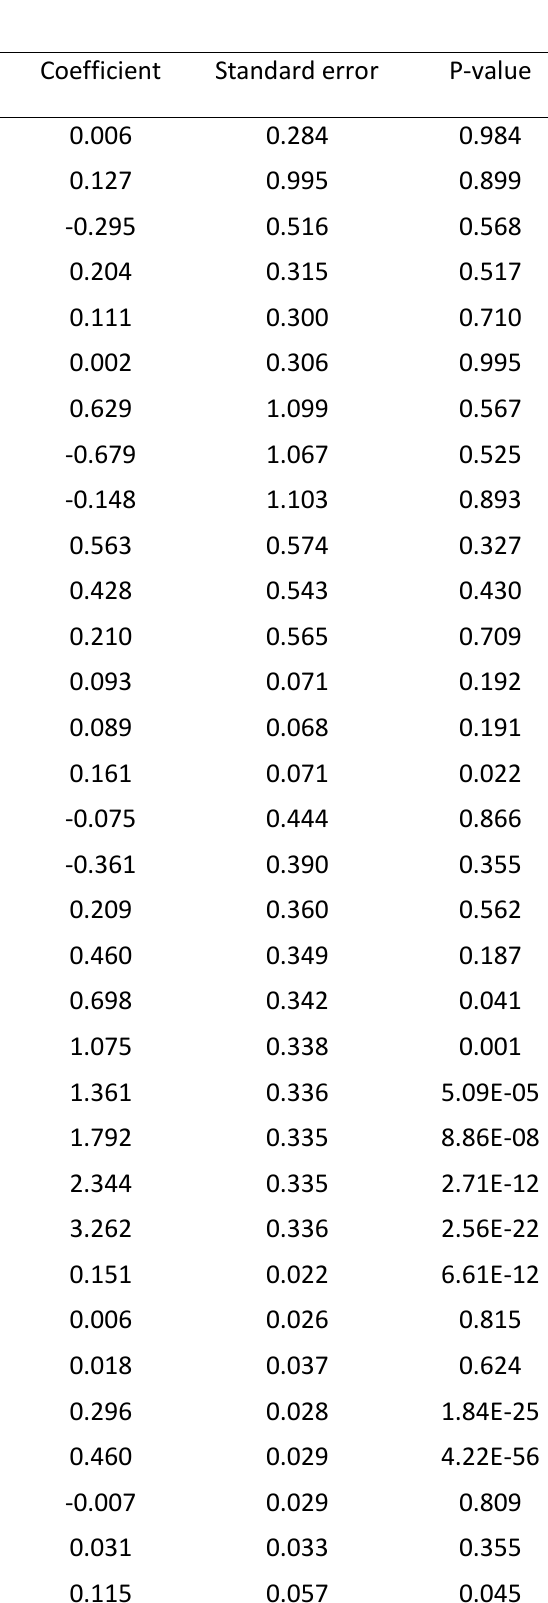
Table S6 . Results from ordered probit regression of life satisfaction on land use variables (a) by age categories, (b) by household income, (c) by financial worries, adjusted for life satisfaction in the past, age categories, sex, household income, financial worries, canton, degree of urbanisation, and month